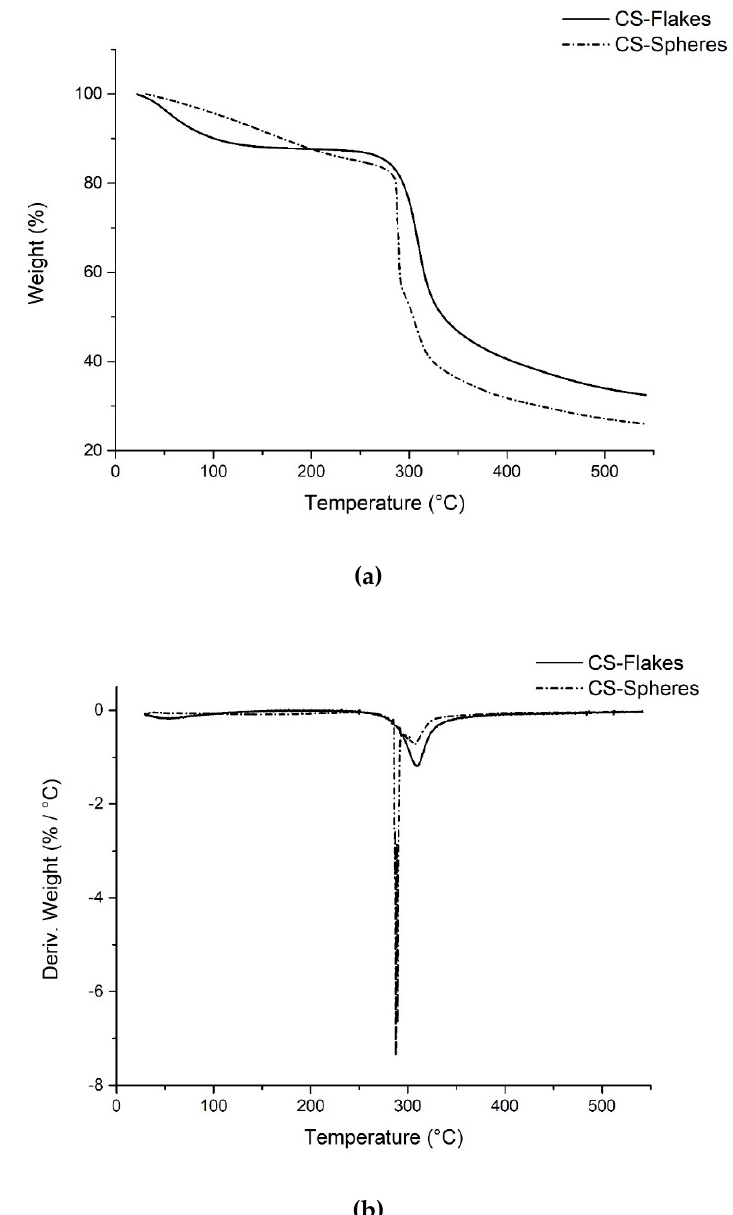
Figure 8. Thermal analysis of CS flakes and spheres: ( a ) TGA curves ( b ) DTGA curves.